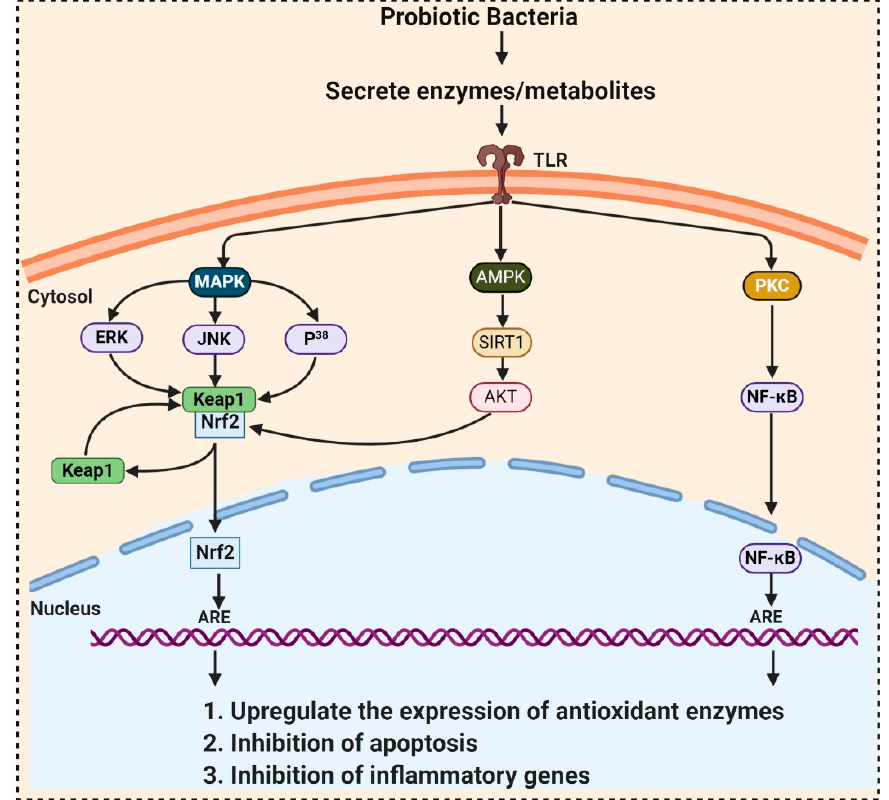
Figure 3. Probiotic activates metabolites and enzymes that enter the cell through toll-like receptors (TLR) and induced Nrf2-Keap1-ARE pathway. During ROS attack, the redox-sensitive cysteine residues of Keap1 react and disrupt the functional conformation of Keap1, thereby activating Nrf2. Nrf2 translocates towards the nucleus and binds to antioxidant response element (ARE) sequences, activating the transcription of ARE-driven genes, encoding antioxidant enzymes, and detoxifying proteins. ROS mediates the expression of redox-sensitive transcription factor NF κ B and further expression of inflammatory cytokines. ROS also activates SIRT1 (Silent information regulator T1), mediated Adenosine monophosphate (AMP)-activated protein kinase (AMPK)